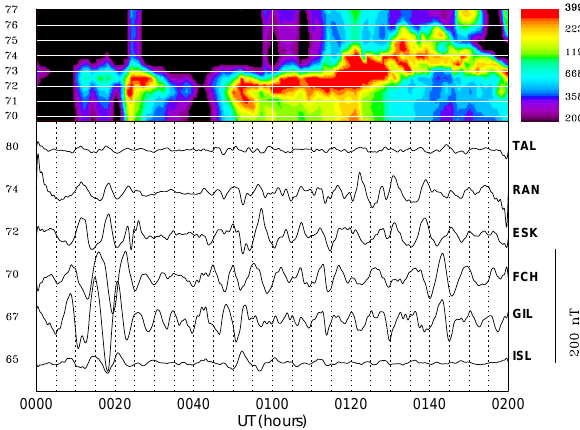
Fig. 5. CANOPUS pulsation activity between 00:00UT and 02:00UT on 10 December 2000: 557.7-nm emission intensity ob- served by the Rankin Inlet MSP as a function of AACGM invariant latitude (top panel) and stacked X -component magnetogram time series (bandpassed between 60–660s) from the Churchill line mag- netometers (bottom panel).